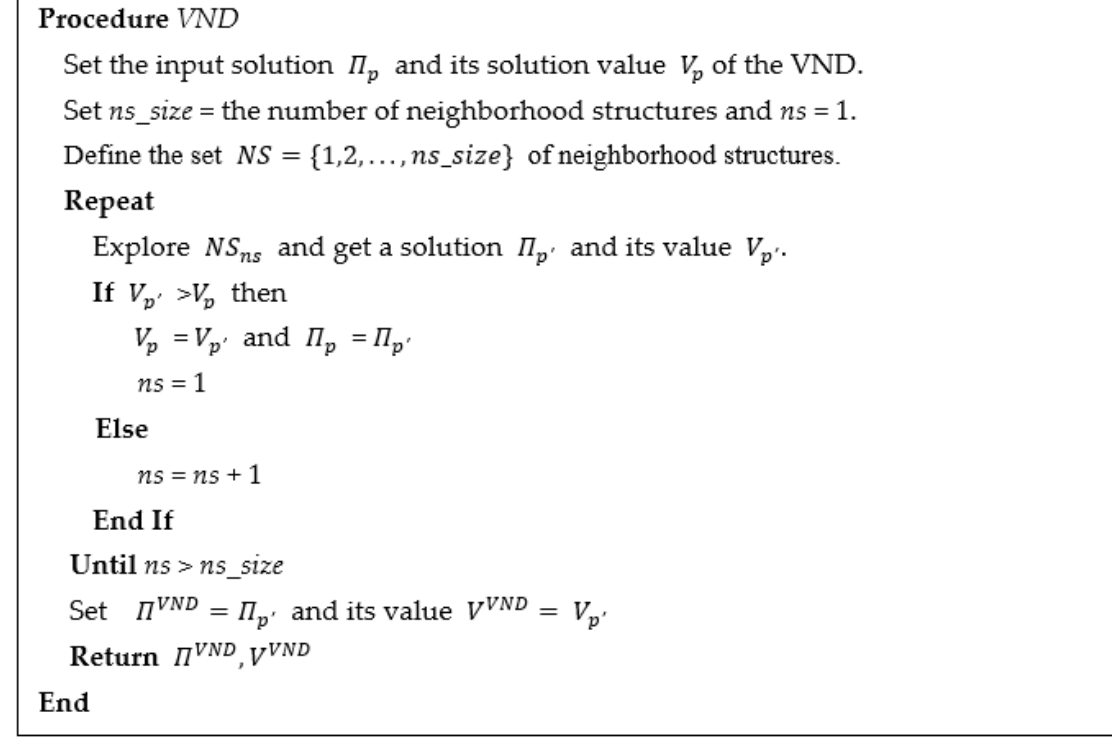
Figure 5. Procedure of the proposed VND.